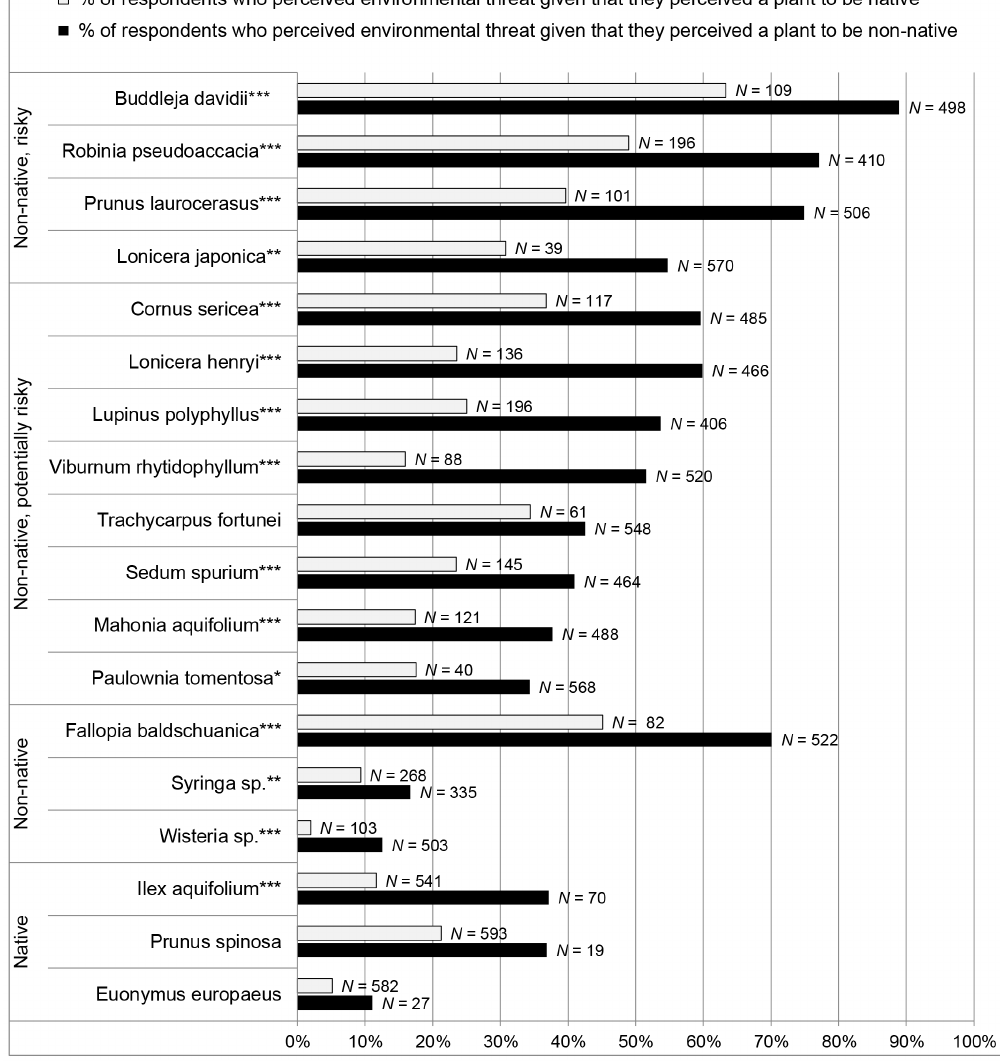
Figure 2. Association of Origin and Risk Perception. The percentages of participants who perceived a plant as an environmental threat depending on the perceived origin of the plant. Note: * p , .05, ** p , .01, *** p , .001, Fisher’s exact test, one-tailed. N corresponds to the number of study participants who classified a plant as either non-native or native.